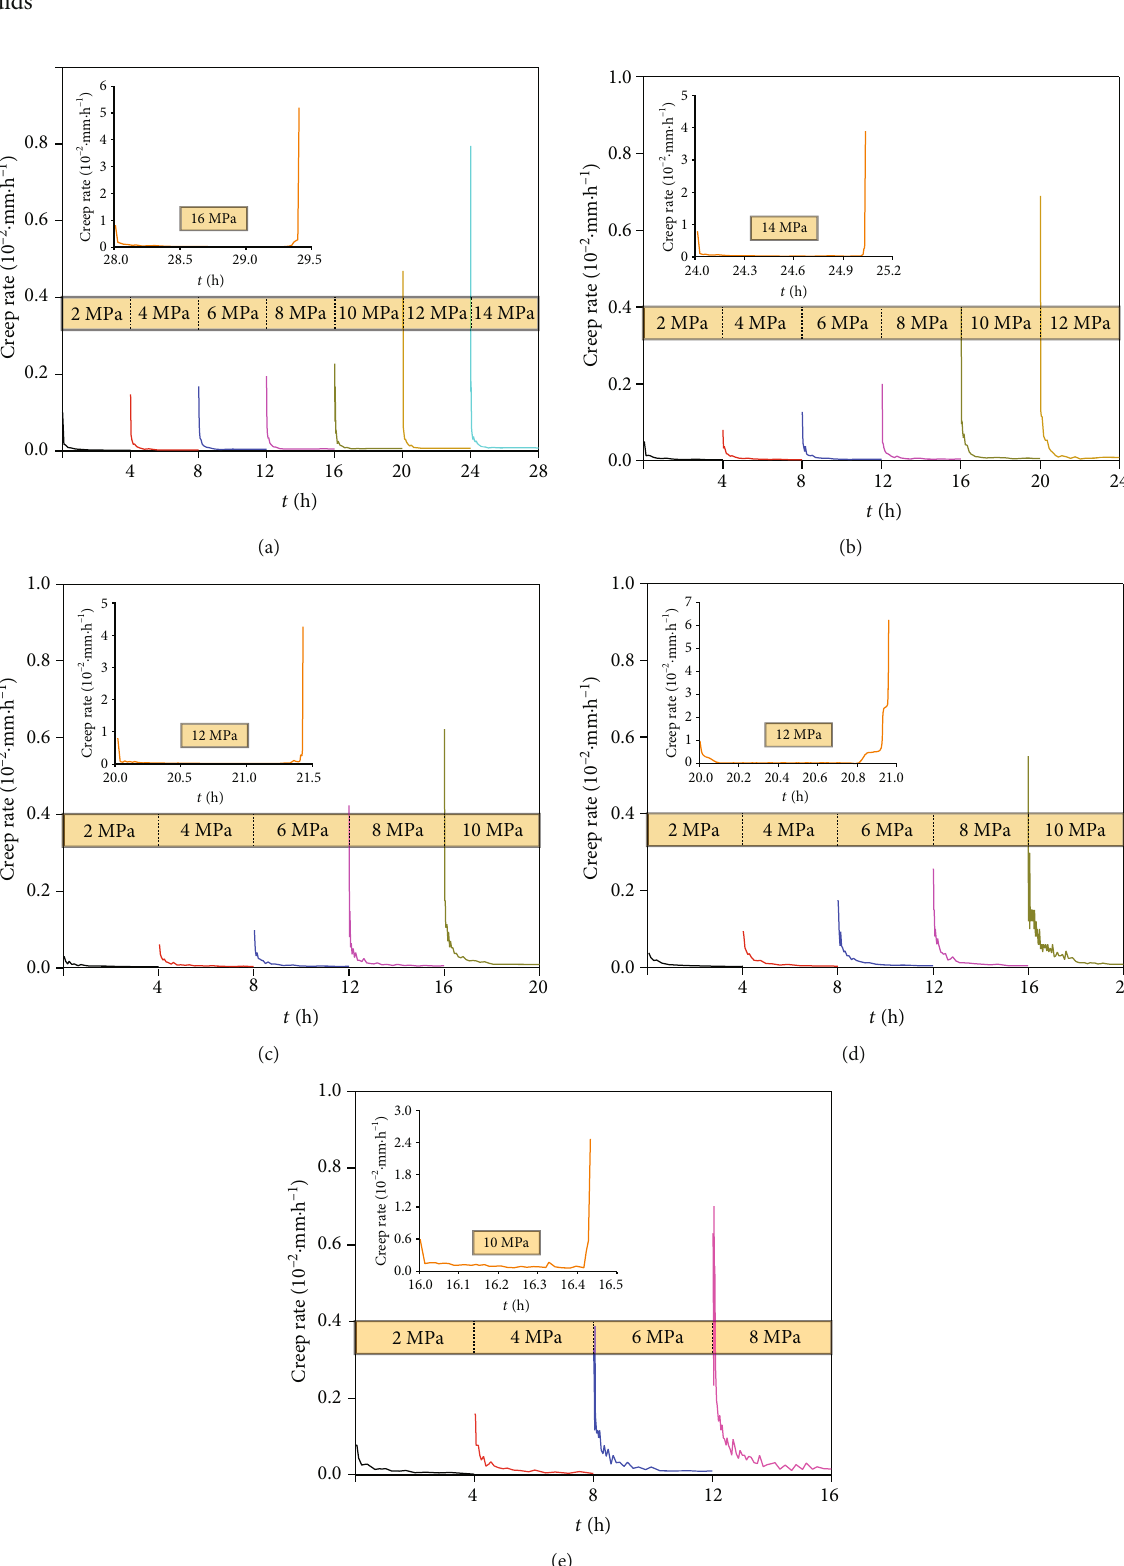
Figure 9: Deformation rate characteristics of coal specimens under di ff erent moisture contents: (a) ω = 0 % , (b) ω = 2 : 42 % , (c) ω = 5 : 53 % , (d) ω = 7 : 55 % , and (e) ω = 10 : 08 %